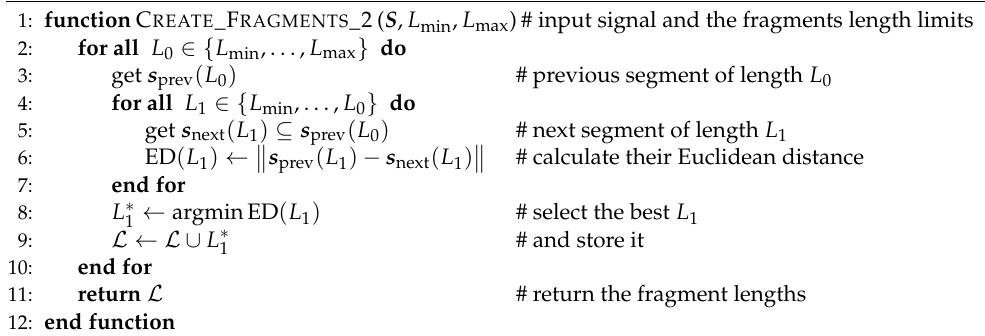
Algorithm 2 The signal fragmentation yielding non-equal size fragments